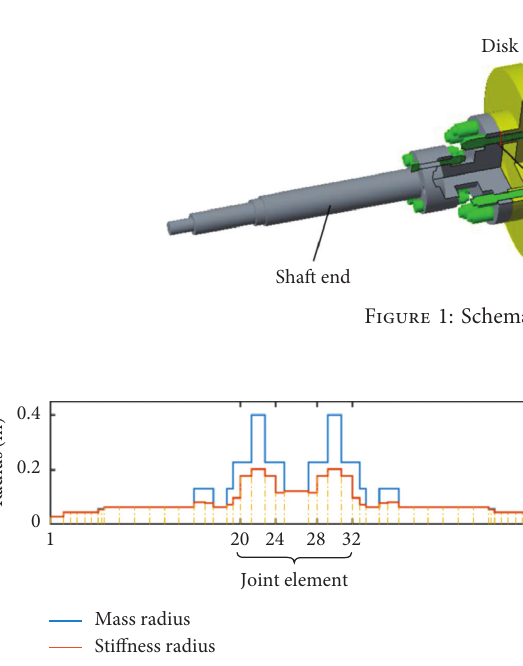
Figure 2: Stiffness radius and mass radius of the tie-bolt rotor.